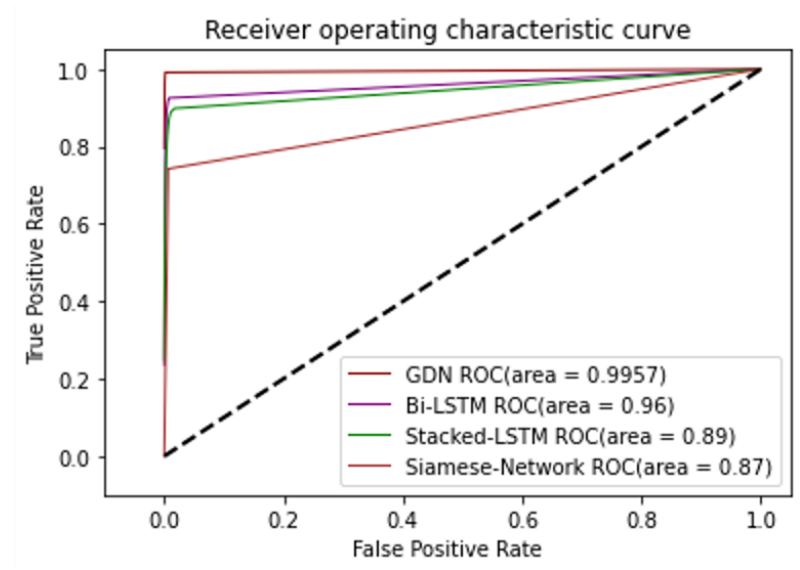
Figure 12. ROC in 10-fold cross-validation technique for different networks.